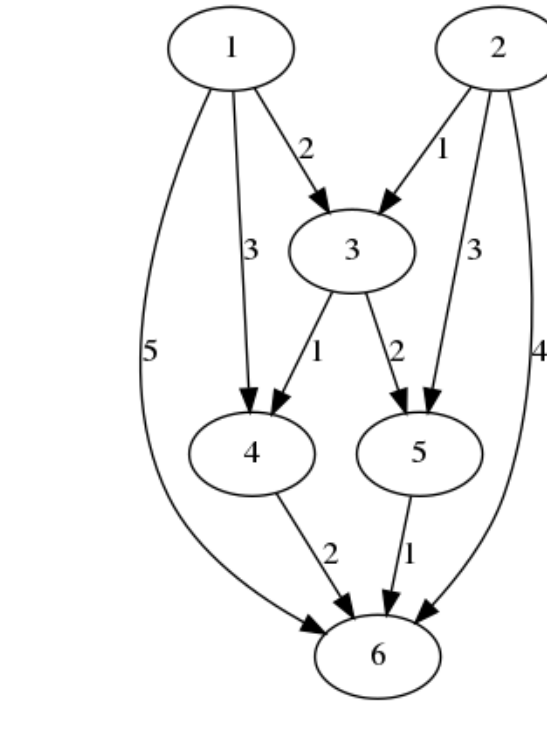
Figure 1: Nice diagrams associated to inequivalent nice bases on the Lie algebra N